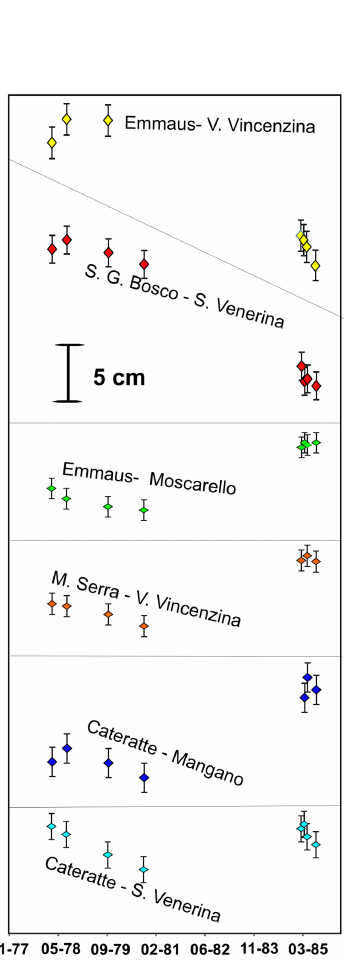
Figure 3. Changes of measured line lengths with respect to time of surveying time (interval 1977–1985) in the Ionica network. Note how the lines are subject to marked variations in the 1980–1984